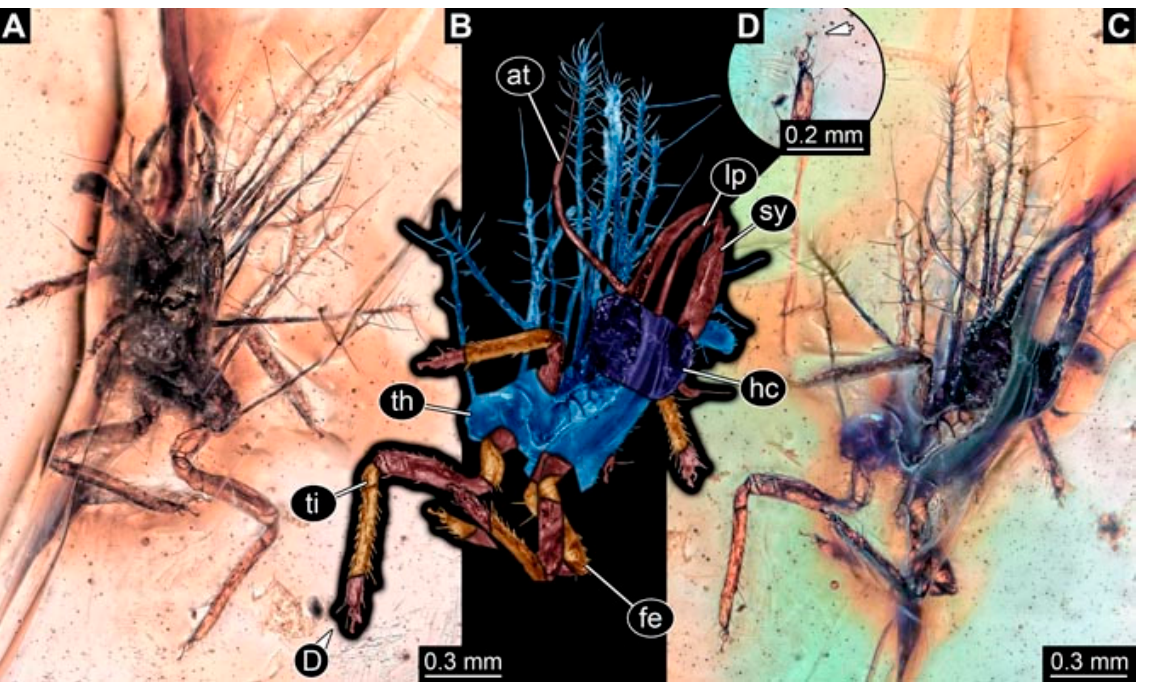
Figure 27. Specimen 4849 (PED 0666); Myanmar amber. ( A ) Ventral view. ( B ) Dorsal view, colour- marked. ( C ) Dorsal view. ( D ) Close-up of distal end of trunk appendage with empodium (arrow). Abbreviations: at = antenna; fe = femur; hc = head capsule; lp = labial palp; sy = stylet; th = thorax; ti = tibia. (31) Specimen 4850 (PED 0667) is preserved in Myanmar amber. It is only accessible in dorsal view (Figure 28A,B). No camouflaging cloak is apparent. The head is roughly